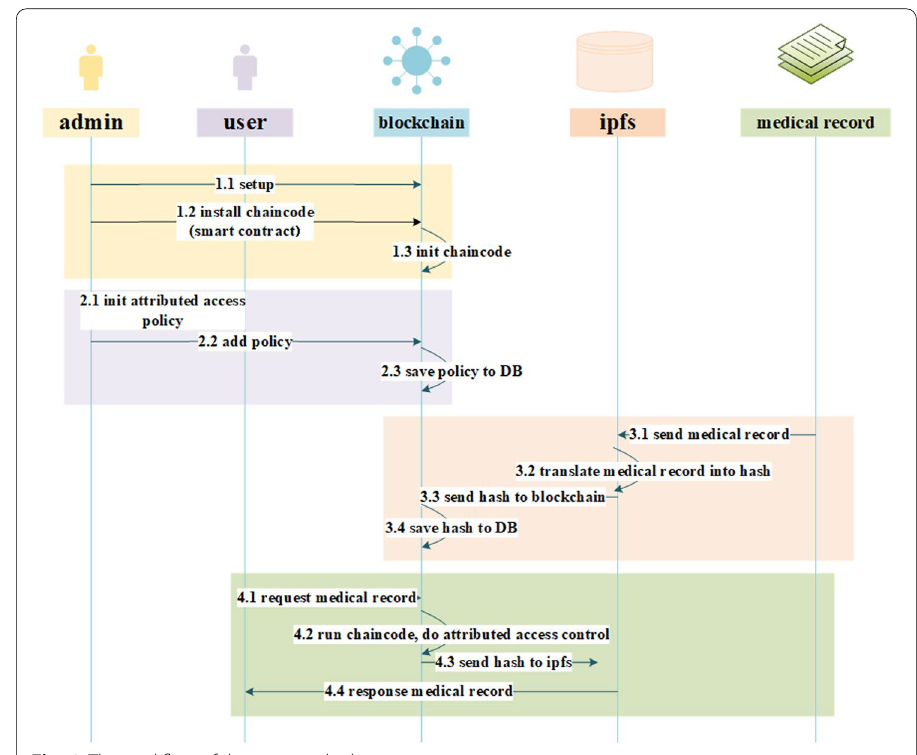
Fig. 6 The workflow of the proposed